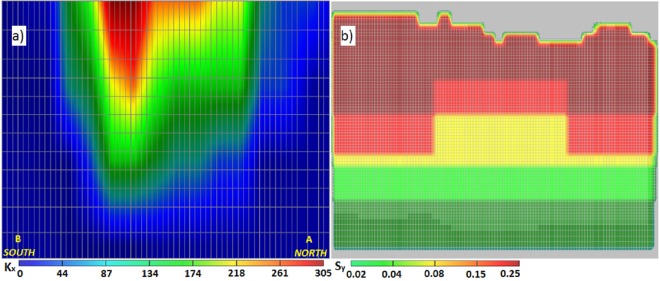
Variability of aquifer hydraulic parameters.(a) Vertical distribution of calibrated hydraulic conductivity (m/day) along cross section A-B (the plot is 50 times exaggerated in the vertical axis); and (b) specific yield of all model layers.